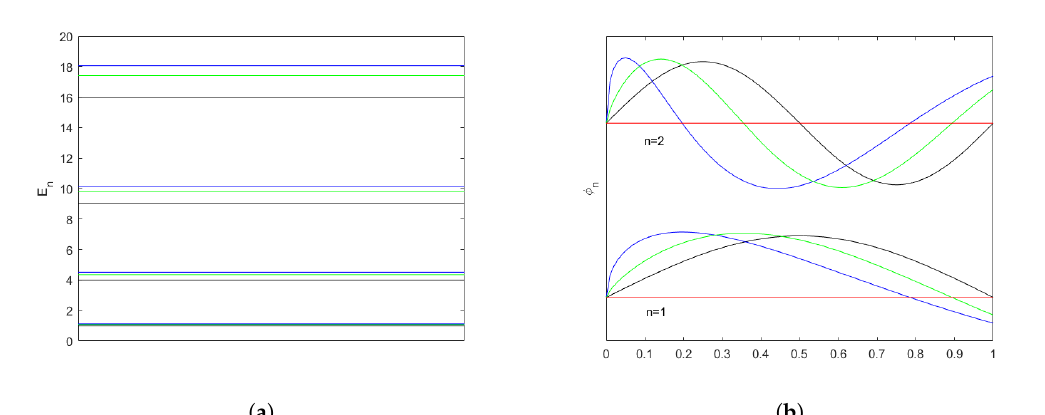
Figure 2. Graph of ϕ α n ( x ) setting n = 1, 2, and α = 1, 0.63.